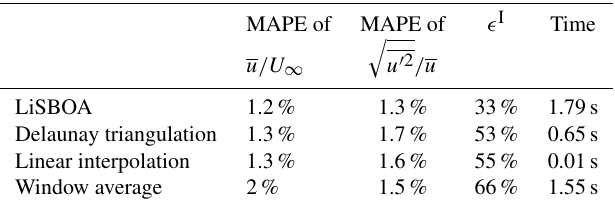
Table 3. Comparison between LiSBOA and other techniques for the retrieval of mean velocity and turbulence intensity from the LES data set through a virtual lidar